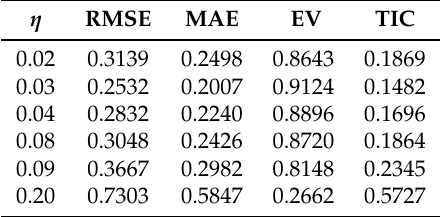
Table 2. The prediction results with different values of η . EV, Explained Variance; TIC, Theil Inequality Coefficient.